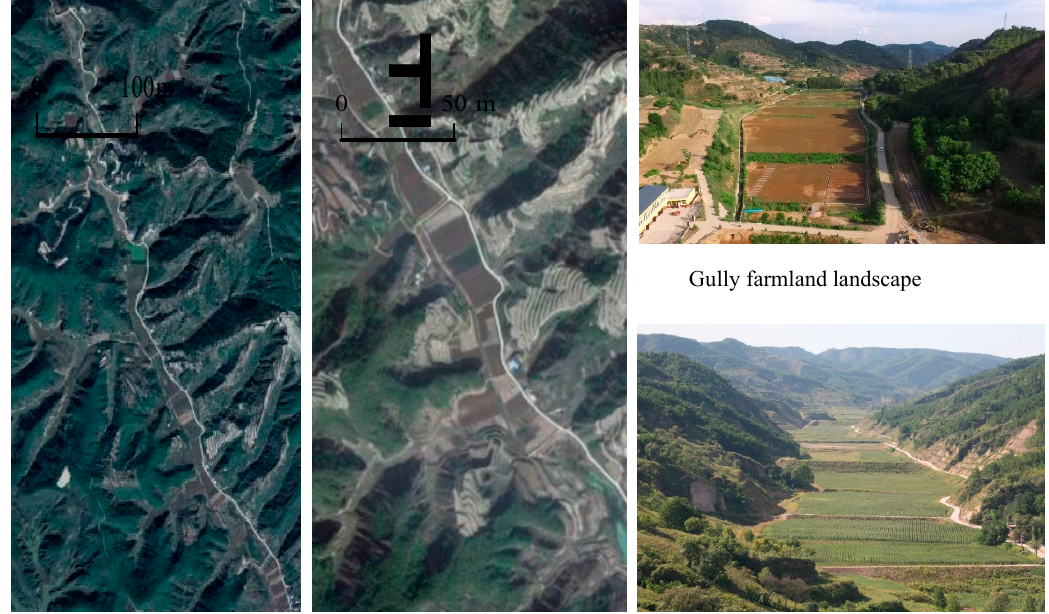
Figure 4. Gully farmland landscape in loess hilly and gully region. Table 1. Reference standards of GUFL types.